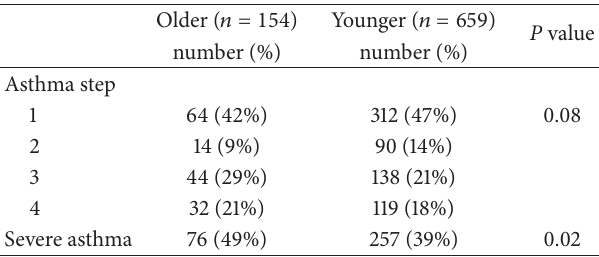
Table 2: Distribution of asthma severity step and severe asthma (step 3 or 4) among older and younger asthma